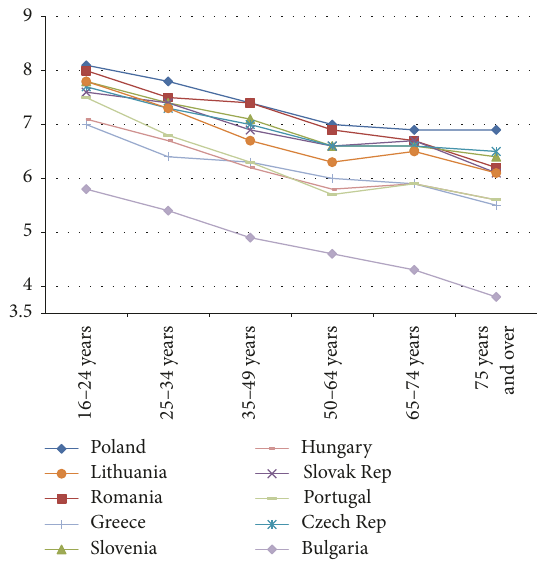
Figure 1: Relatively large decline in life satisfaction by age 2013.